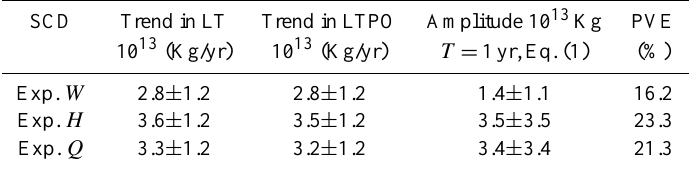
Table 2. SCD for the whole basin between 0 and 2000m; the uncertainty is at the 95% confidence level. SCD Trend in LT Trend in LTPO